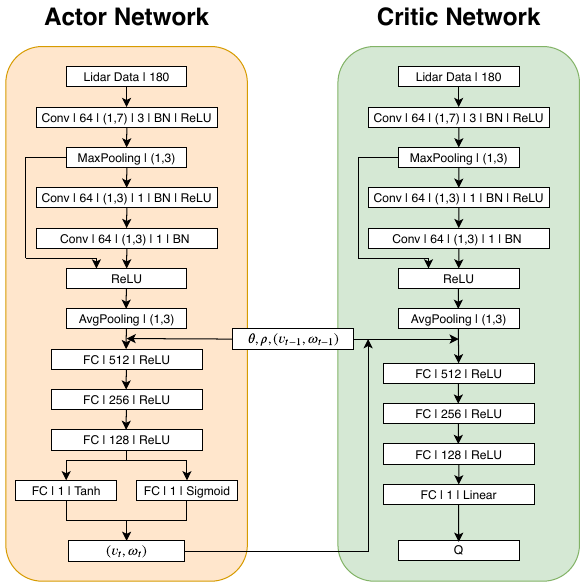
Figure 1. The structure of the modified Deep Deterministic Policy Gradient for single robot mapless navigation